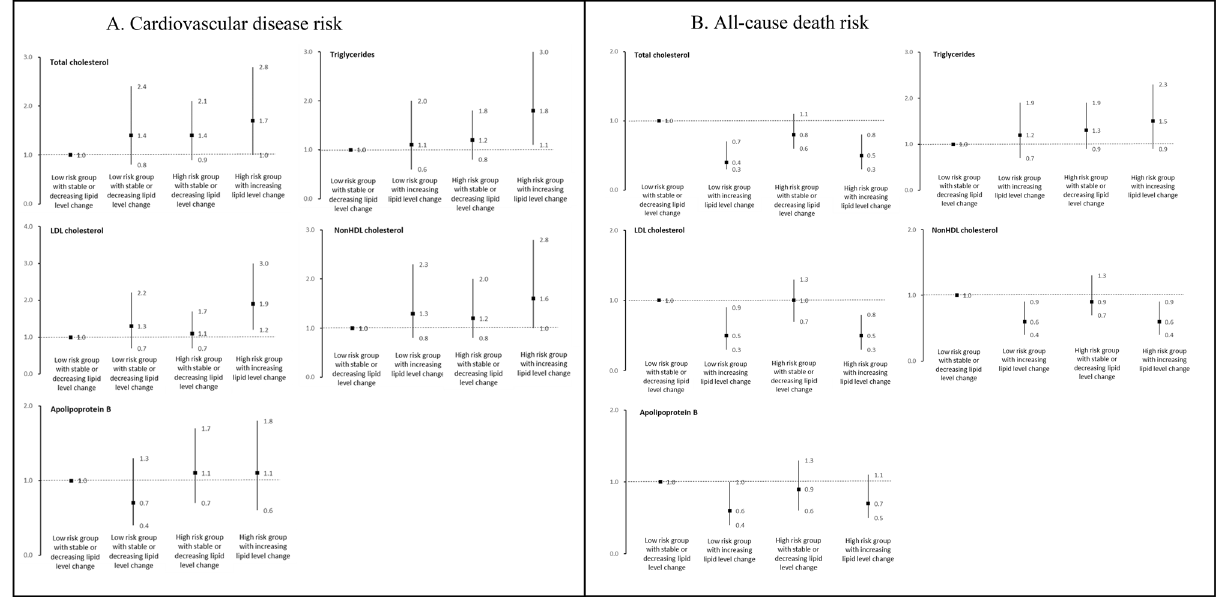
Figure 2. Joint effects of baseline lipid profile and the change of lipid change for cardiovascular disease and all-cause death risks. Hazard ratios were adjusted for age groups (20–64/ ≥ 65 years old), sex, body mass index (18.4/18.5–23.9/24.0–26.9/ ≥ 27 kg/m2), current smoker (yes/no), alcohol drinking (yes/no), marital status (single, divorced or separated/Living with spouse), regular exercise habit (yes/no),education level (9